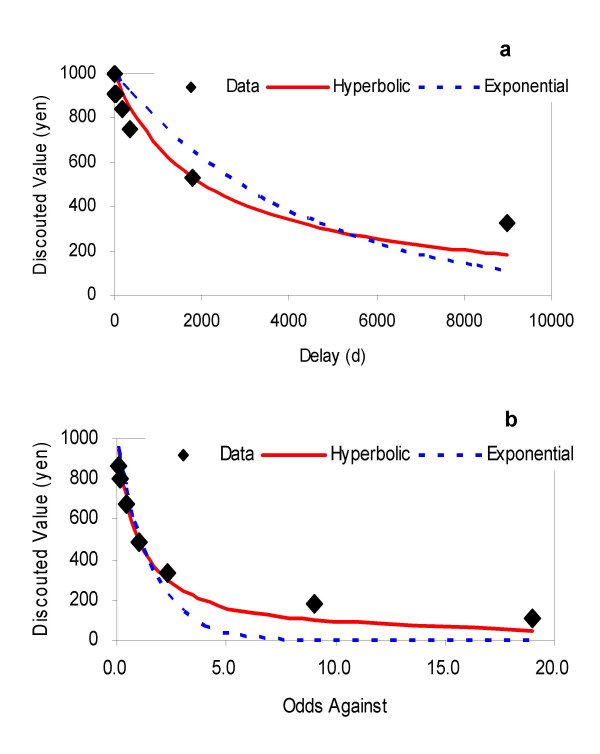
The solid (red) and dotted (blue) curves are the hyperbolic and exponential functions respectively, best fitted to the experimental data in delay and probability discounting tasks (a-b) (see Methods). Fig. 1a: Vertical axis indicates group median of indifference point in delay discounting task (discounted present value) and horizontal axis indicates delay (days). Data points are represented by the black diamonds. Fig. 1b: Vertical axis indicates group median of indifference point in probability discounting task (certainty equivalent discounted value) and horizontal axis indicates odds-against = (1/probability)-1 (an average waiting time in Rachlin's virtually-repeated gambling [17]). Note that hyperbolic models (red) better fit than exponential models (blue) (see Table 1 for AICc for each model).